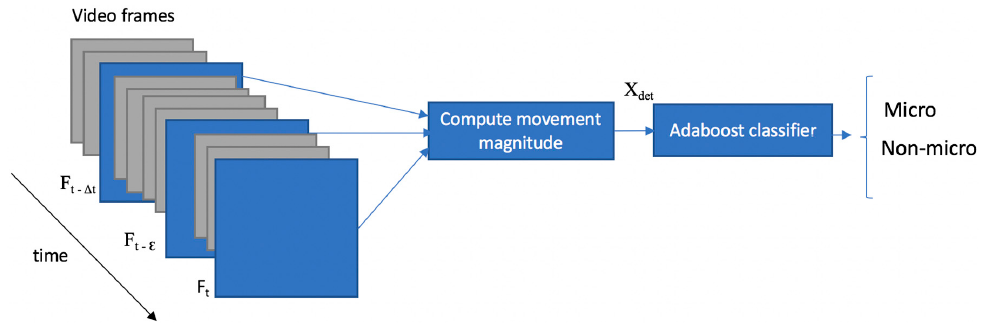
Figure 6. ME detection framework. The frames that are analyzed by the ME detection module at time t (F t − τ /2 , F t − ε and F t ) are depicted in blue, while the other frames from the micro-expression sequence are depicted in